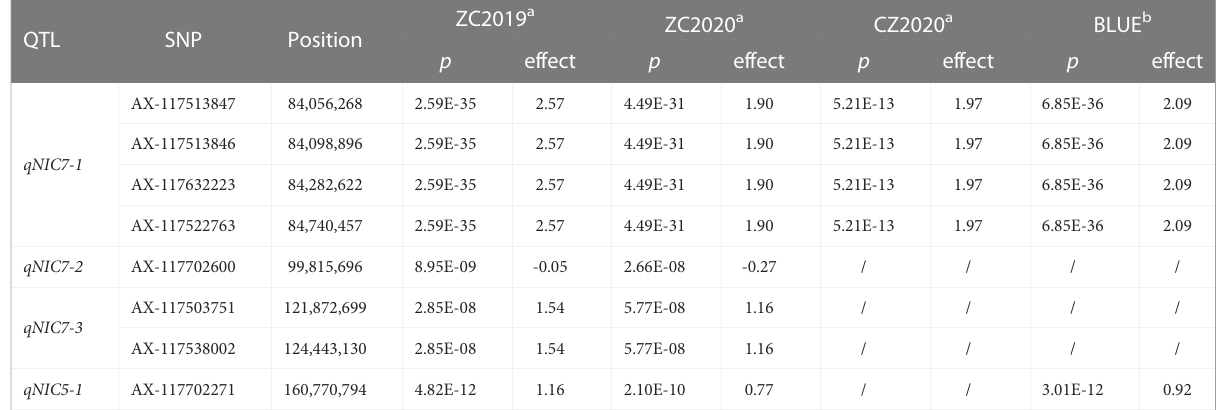
TABLE 2 Summary of QTLs associated with nicotine content in tobacco across different environments.